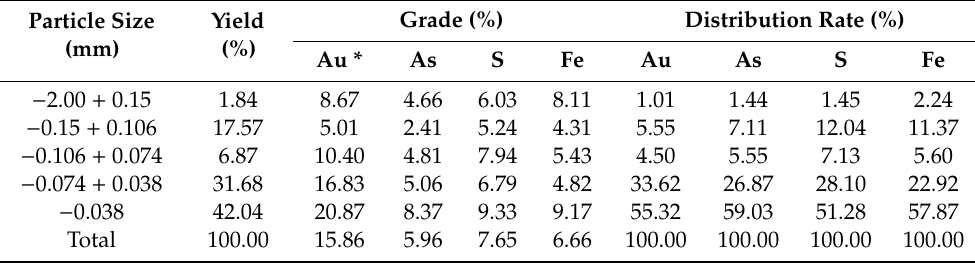
Figure 10. The results of gravity separation as a function of grinding fineness ( A ); and as a function of the number of gravity separations ( B ). Table 4. The characteristics of the grinding products